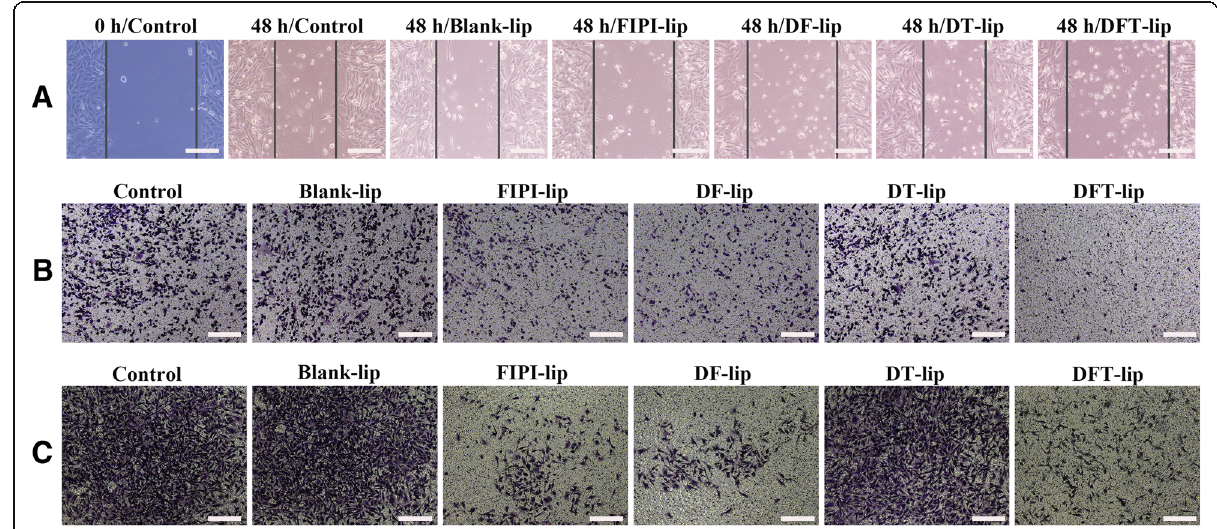
Fig. 6 In vitro anti-metastasis study of the liposomes. a Inhibition effects on the cell motility in vitro. Images of MDA-MB-231 cells wound edge after incubation with control, Blank-lip, FIPI-lip, DF-lip, DT-lip, and DFT-lip for 48 h, respectively (magnification, × 100). b Inhibition effects on cell migration. Images of MDA-MB-231 cell migration after incubation with control, Blank-lip, FIPI-lip, DF-lip, DT-lip, and DFT-lip for 7 h at a concentration of 2 μ M FIPI (magnification, × 100). c Inhibition effects on the cell invasion. Images of MDA-MB-231 cell invasion after incubation with control, Blank-lip, FIPI-lip, DF-lip, DT-lip, and DFT-lip for 24 h a concentration of 2 μ M FIPI (magnification, ×